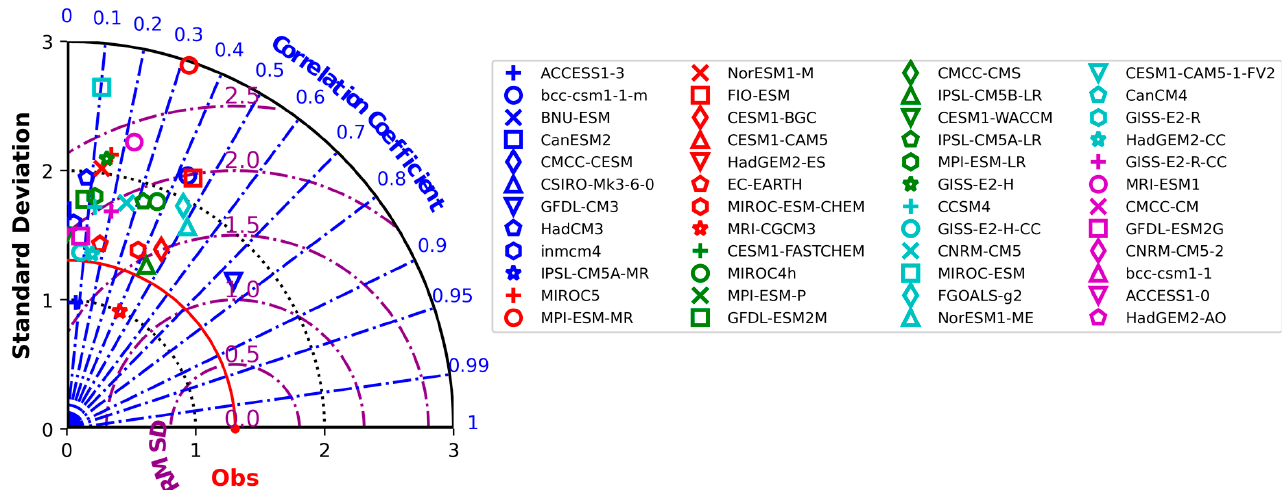
Figure 2. Taylor diagrams of December t2m anomalies for the CMIP5 models as compared to the observations (red dot, obtained from ERA5 reanalysis) over the North China region (110°–120° E, 35°–45° N). Ten years (1995–2004) of data were used for the analysis.